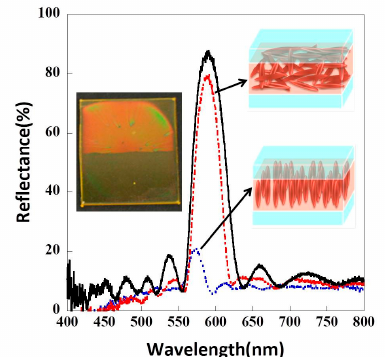
Figure 9. Change in reflection spectra of the P6Az/polyvinyl alcohol films (PVA) 20-multi-bilayered film before (black solid line) and after irradiation of unpolarized visible light (436 nm, 140 mW/cm 2 , 10 min; blue dotted line) and following UV light (365 nm, 40 mW/cm 2 , 10 min; red dash-dot line) [42].